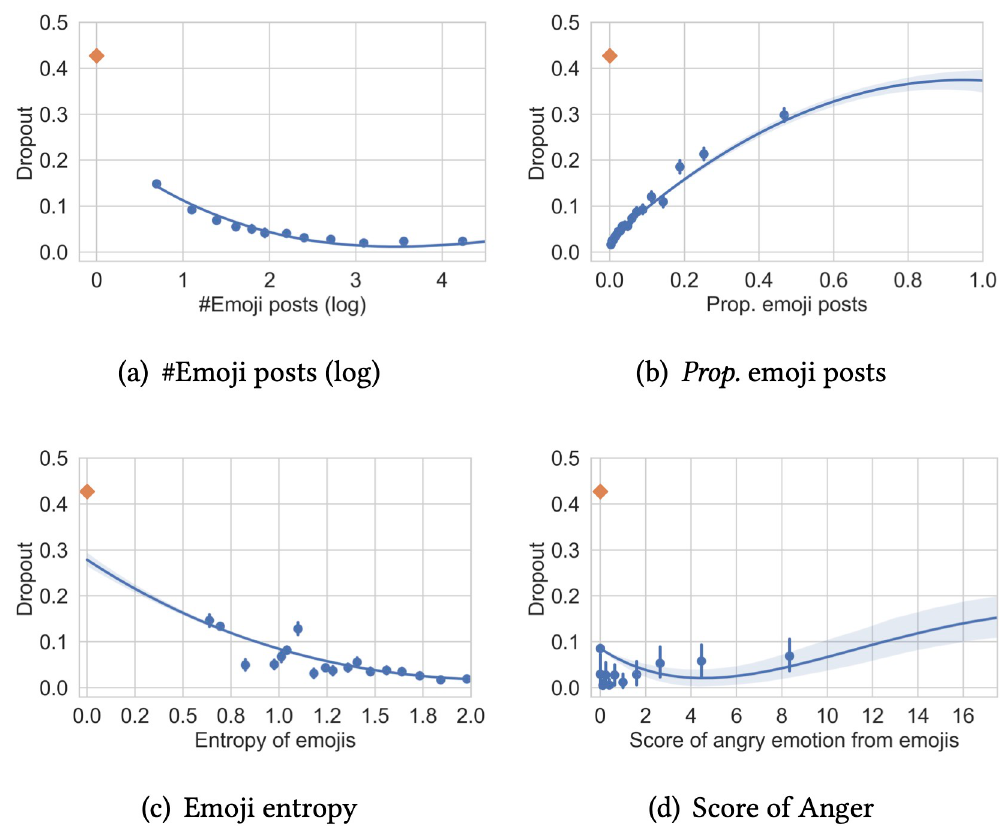
Fig 6. Relation between selected emoji usage features and dropout risk (10% active users by avg . working hours). Blue dots: bins of emoji users; orange diamond: non-emoji users. (a): #Emoji posts (log). (b): Prop . emoji posts. (c): Emoji entropy. (d): Score of Anger emotion.